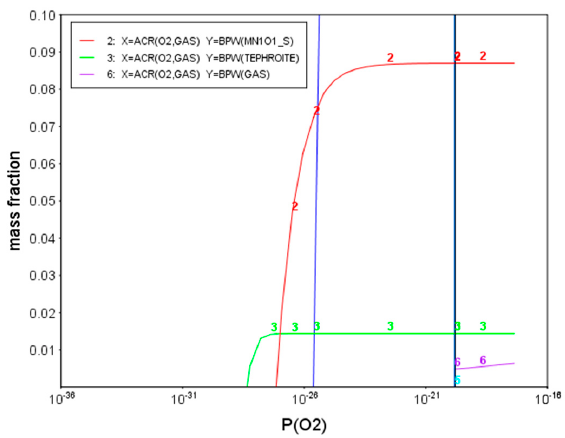
Figure 8. Variation of the formation of oxide with oxygen potential pressure obtained by thermodynamic calculation.